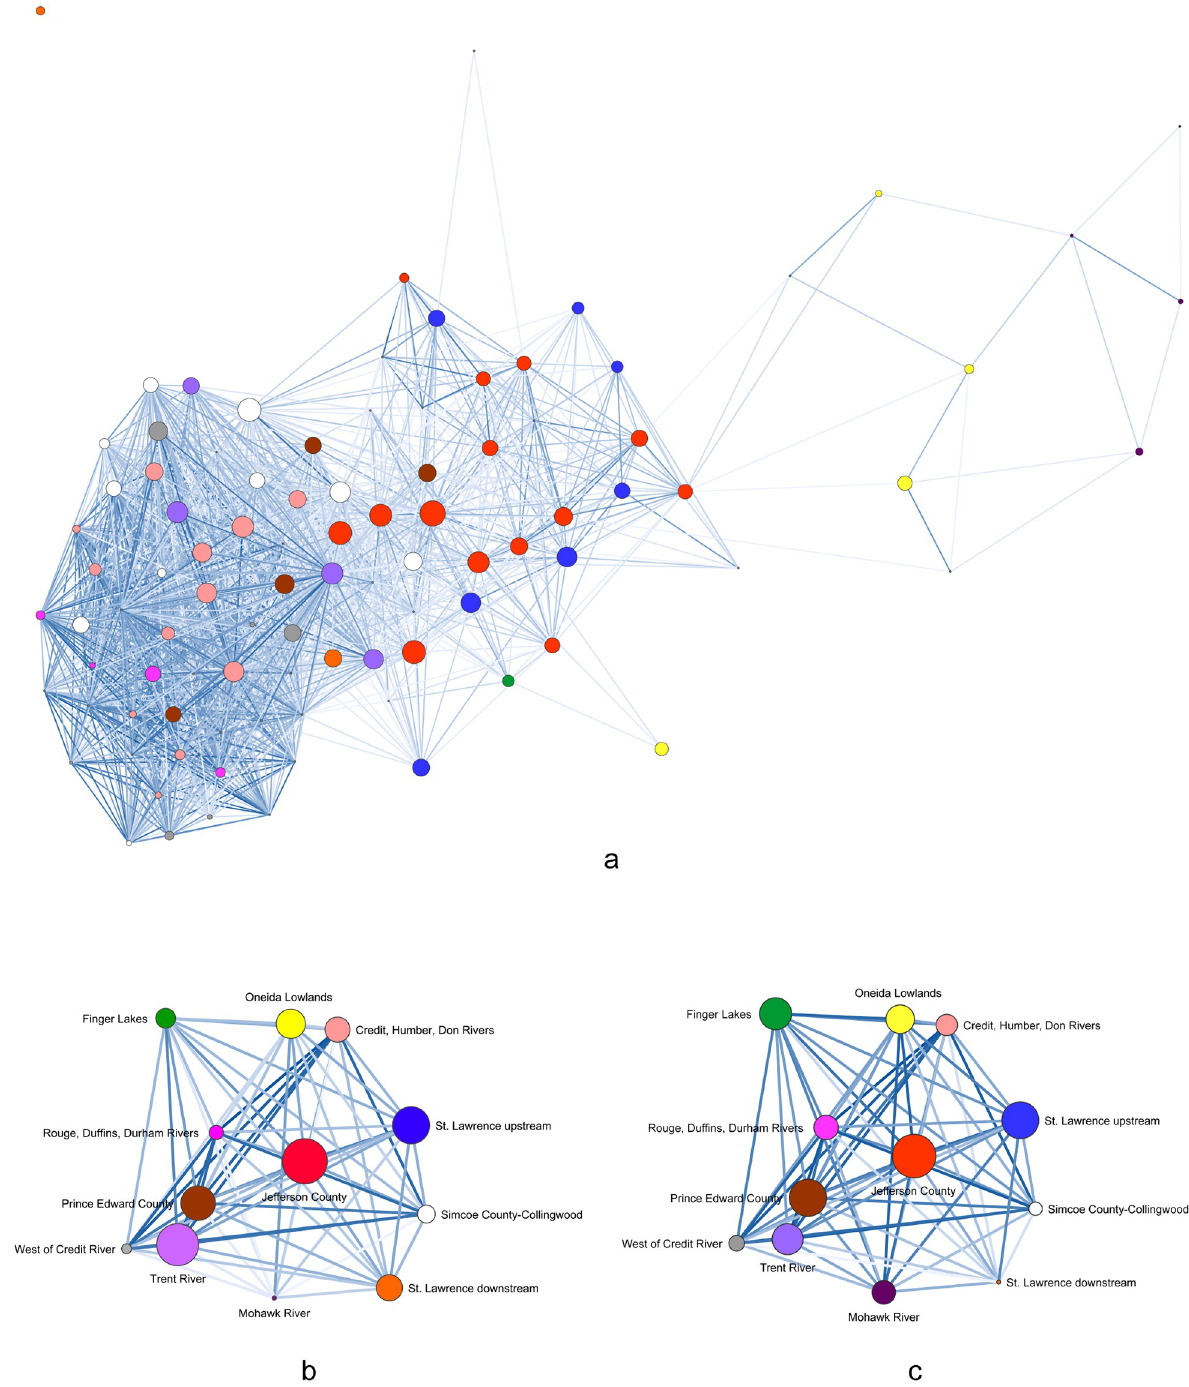
Fig 5. AD 1400–1500 network visualizations. (a) BR site-level network with threshold of � 0.50 and spring embedder layout, (b) weighted BR centroid network with metric multidimensional scaling (MMDS) layout, (c) weighted LCP similarity centroid network with MMDS layout. Node size based on potential brokerage